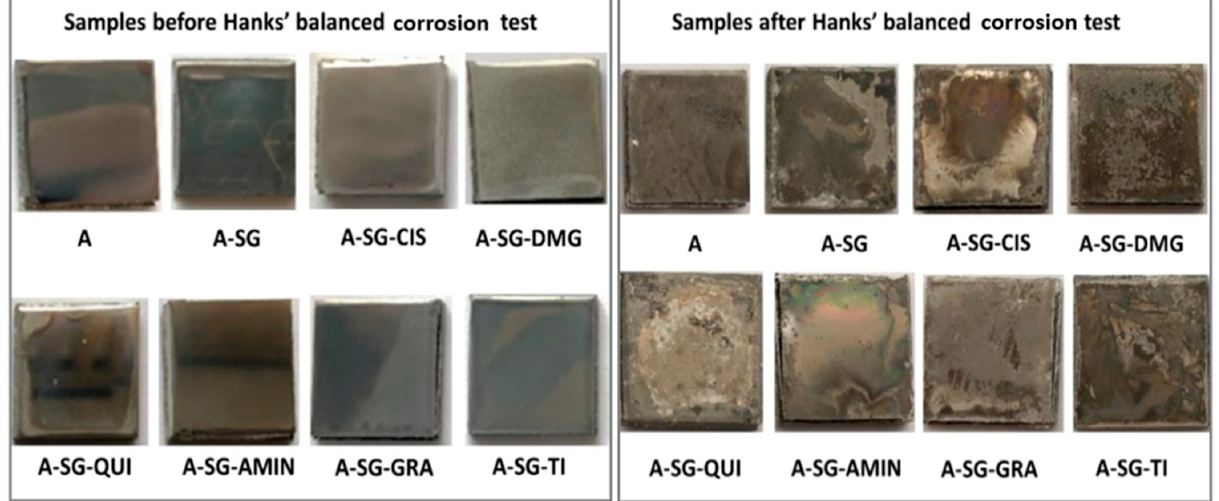
Figure 2. Morphological scans of the surface (3 mm × 3 cm) of the Mg-Al sample; undipped and dipped in an HBSS following 14 days for specimens. Reprinted with permission from Ref. [36]. MDPI (2022).